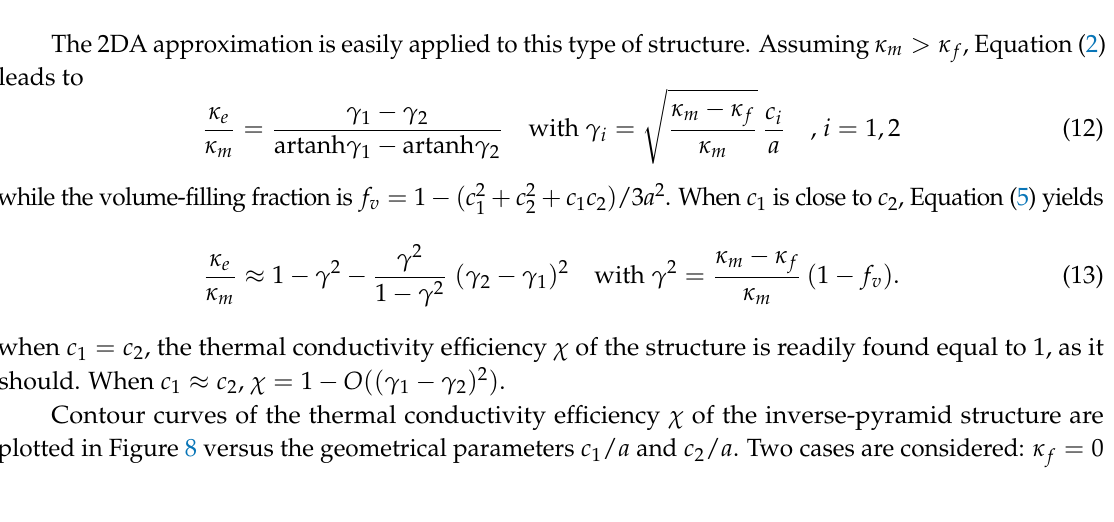
Figure 7. Top view and side view of an open structure with truncated square pyramidal holes. The picture on the left is a 3D-printed model produced with a carbon black filled PLA